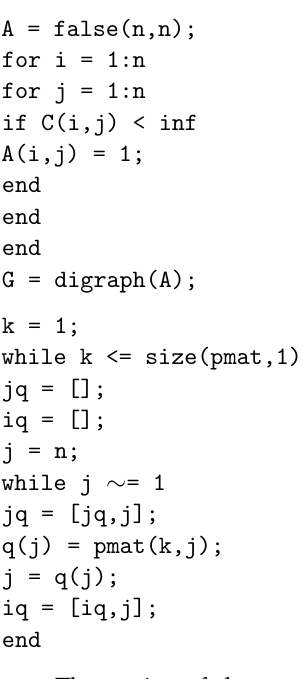
F = plot(G,’lineWidth’,6.7,’Markersize’,6.7); highlight(F,iq,’Nodecolor’,’r’) highlight(F,iq,jq,’LineStyle’,’:’,’Edgecolor’,’r’) highlight(F,[1,n],’Nodecolor’,’y’) Any rows representing duplicate paths are deleted from pmat , and counters increase according to size